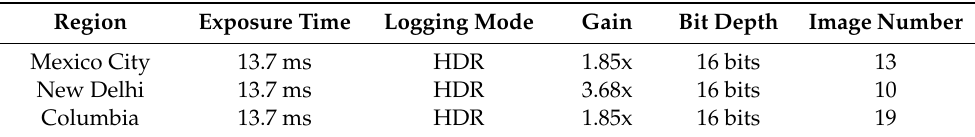
Table 4. Working status and parameter setting of image